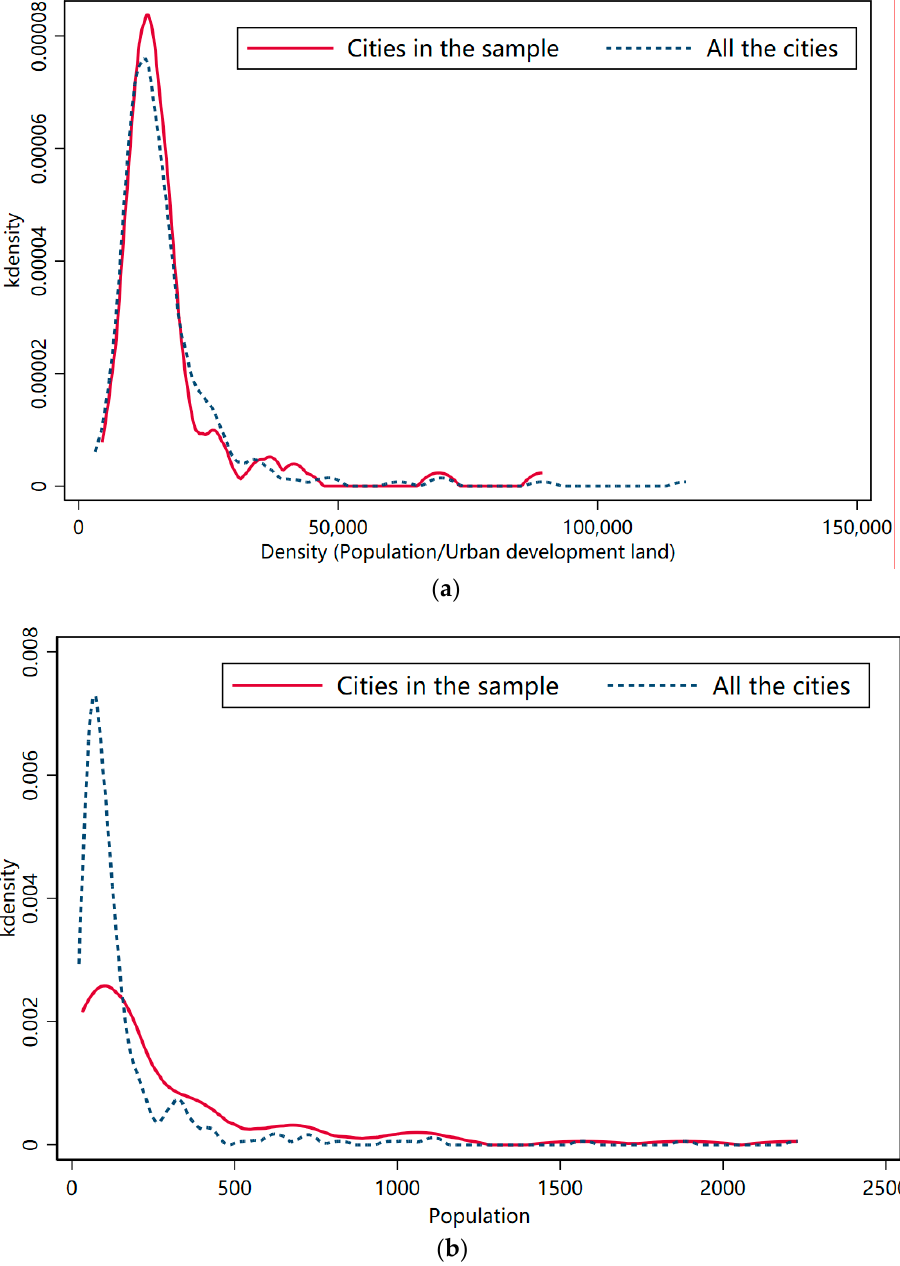
Figure 1. Kernel density estimate of urban density ( a ) and population ( b ).